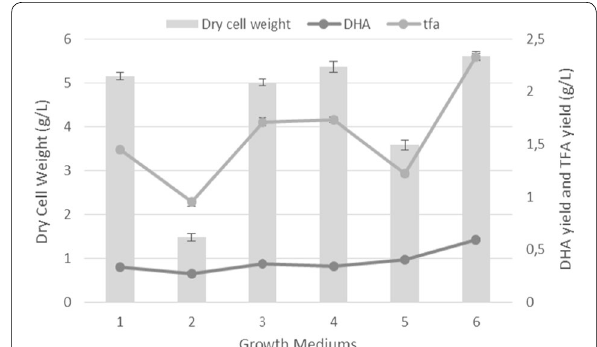
Fig. 2 Dry cell weight, Total fatty acid yield and DHA yields in CM (1), CM E (2), FM (3), TM (4), GM (5) and PPM (6) media +